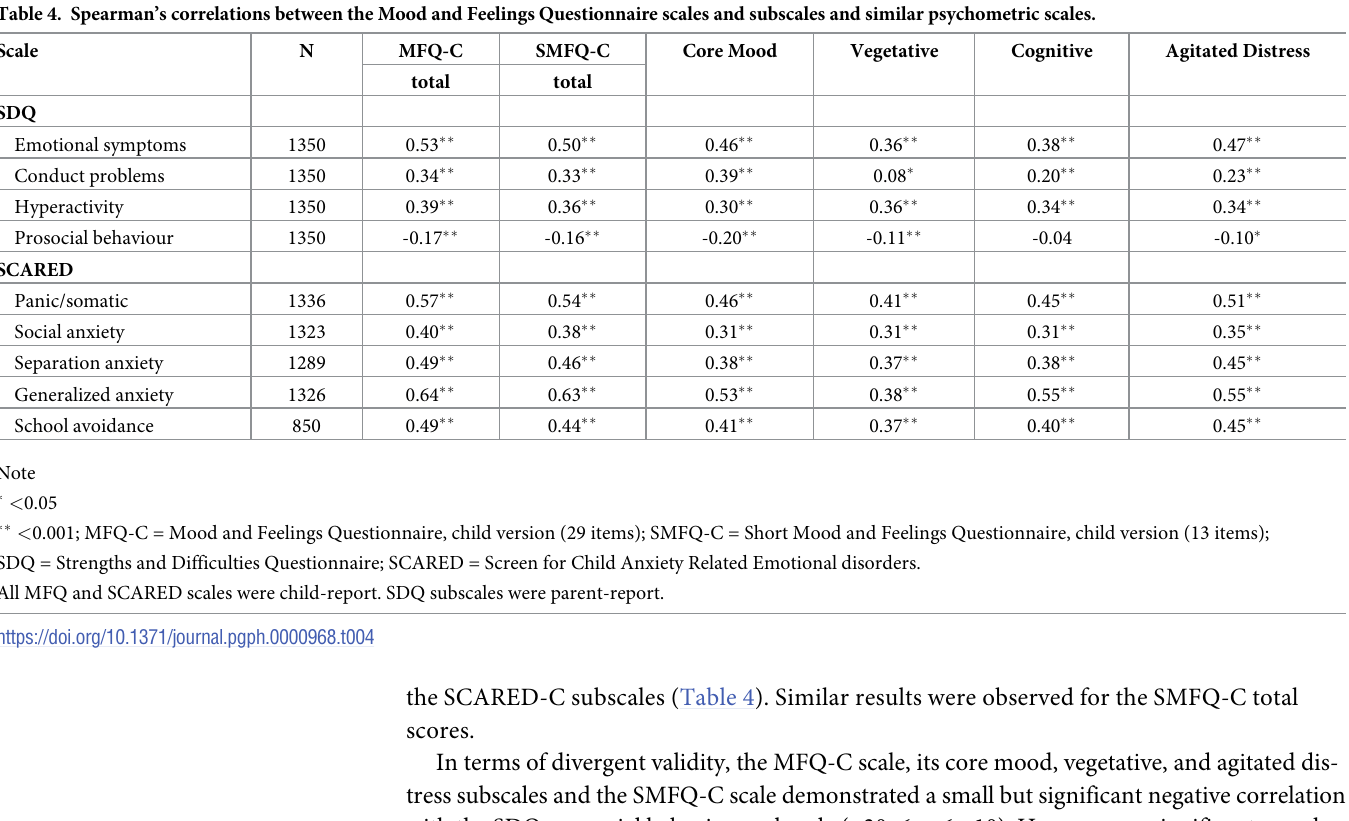
the SCARED-C subscales (Table 4). Similar results were observed for the SMFQ-C total scores.